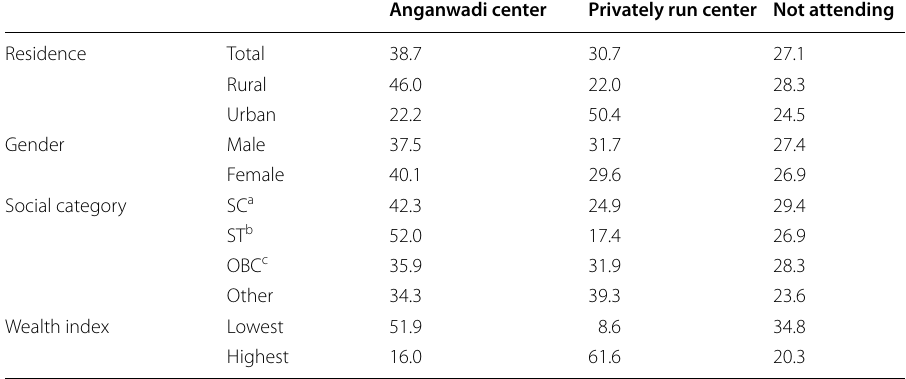
Source: Government of India (2016) a Scheduled